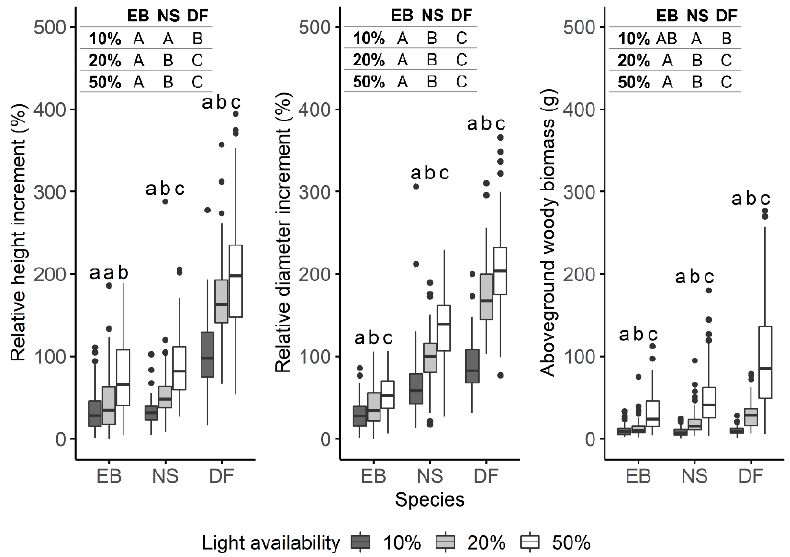
Figure 3. Relative height and diameter growth (%) and aboveground woody biomass (g) production along the light gradient. The letters above the boxplots indicate intraspecific differences across light levels. The tables above every figure show interspecific differences between three species under different light levels. Different letters indicate significant differences ( p < 0.05). Light availability levels range from 10–50%. Species are arranged from most to least shade-tolerant [44,45]. Species: EB—European beech, NS—Norway spruce, DF—Douglas fir.